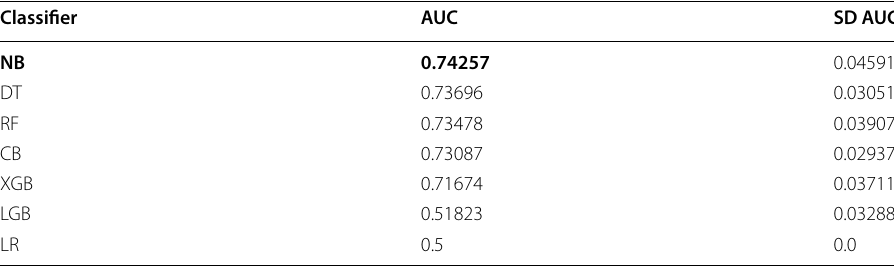
Bolded values indicate highest scores